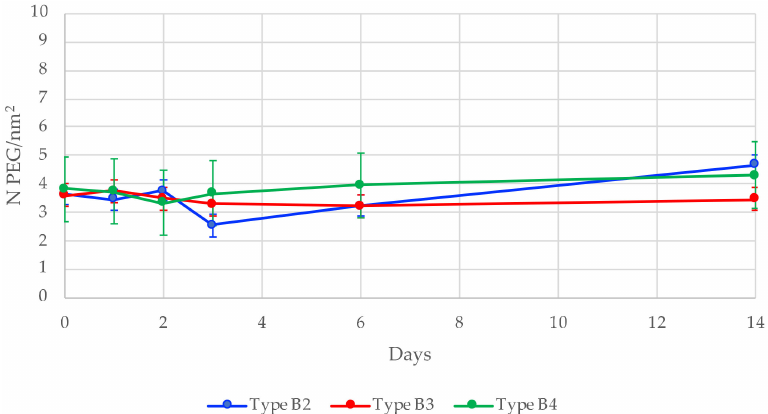
Figure 6. Grafting stability of B2 , B3 , and B4 nanoparticles through time, with respectively three, two, and one anchoring